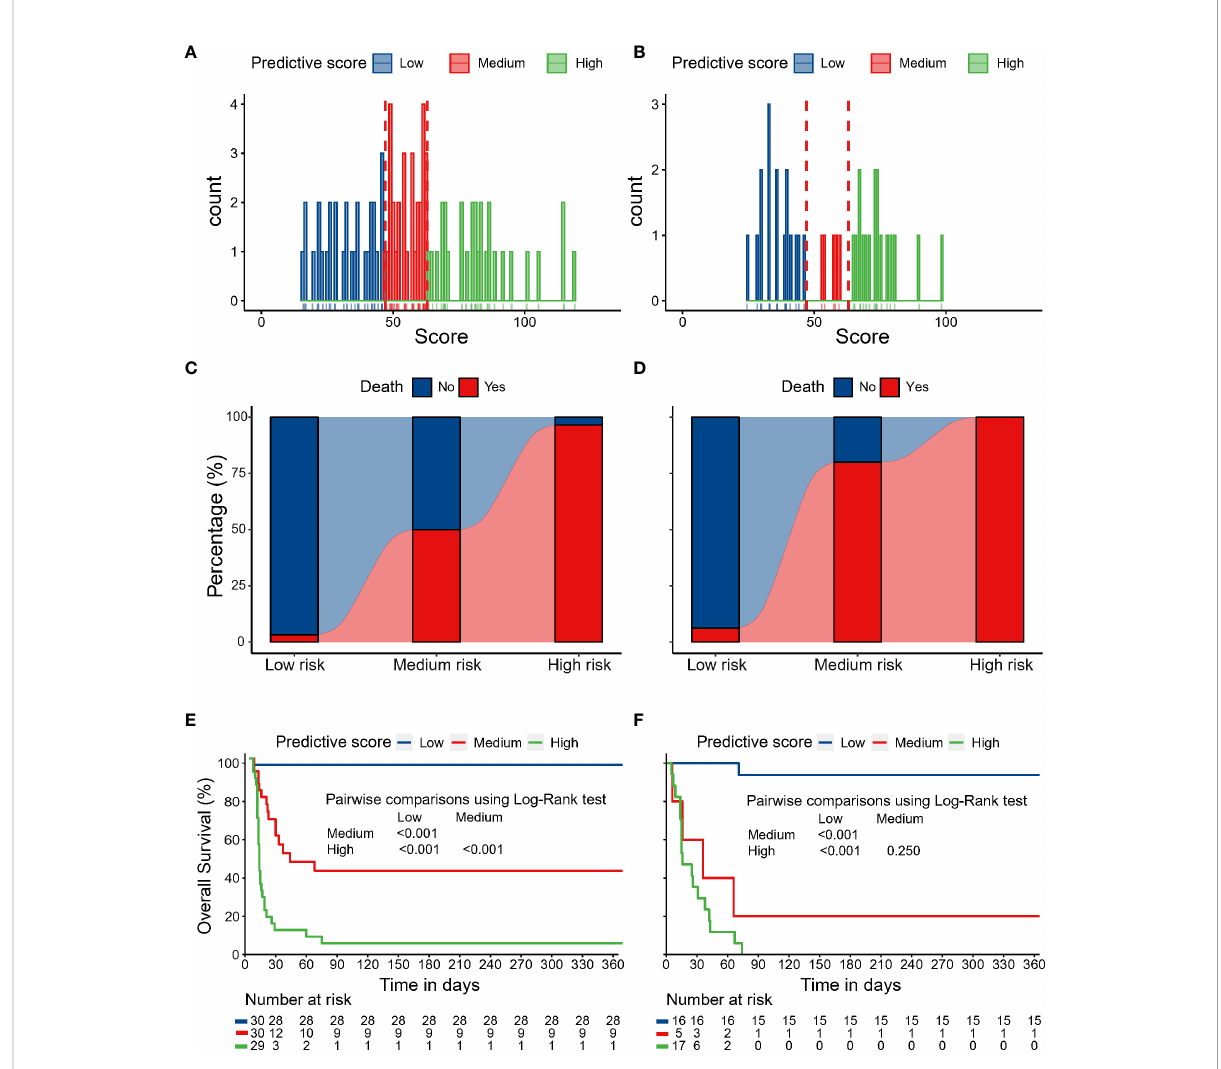
FIGURE 5 The distribution of nomogram scores in the discovery cohort (A) and temporal validation cohort (B) . Patients with higher nomogram scores were associated with higher mortality risk within one year in the discovery cohort (C) and temporal validation cohort (D) . Survival analyses revealed that patients in different risk groups had distinct survival probabilities at one year in the discovery cohort (E) and temporal validation cohort (F)